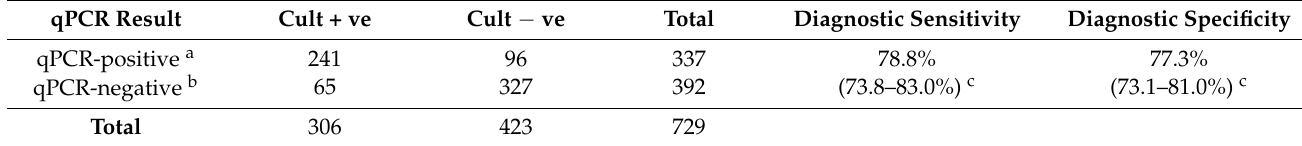
Table interpretation. Cult + ve = culture-positive, Cult − ve = culture-negative, a When qPCR value was higher than 1.75 × 10 3 ; b when qPCR value was lower or equal to 1.75 × 10 3 ; c 95% confidence interval of diagnostic sensitivity and